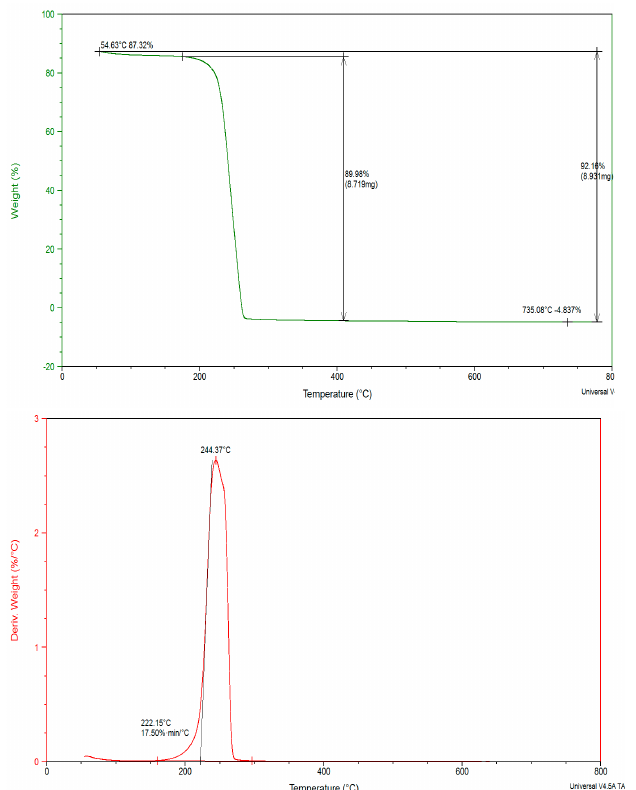
Figure 3. Thermal gravimetric analysis and differential thermal analysis thermograms of proline.